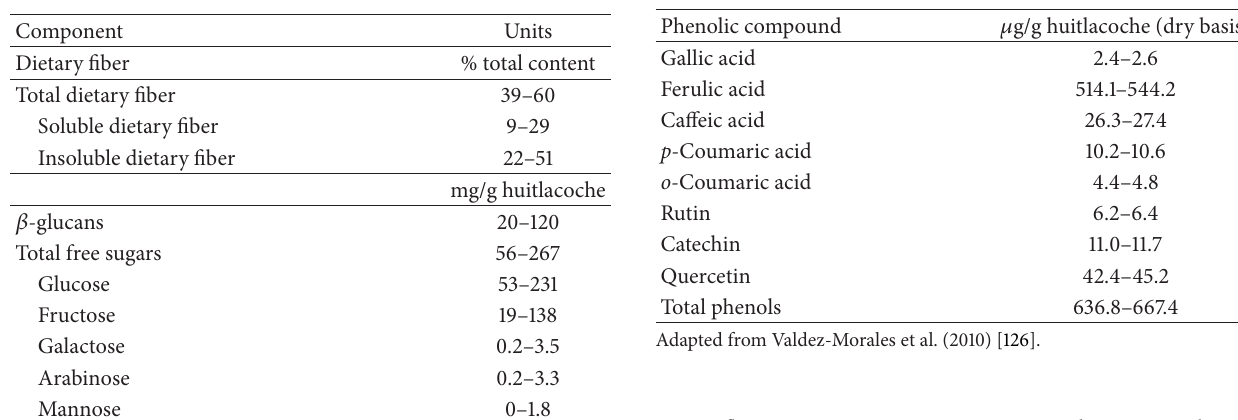
Table 4: Dietary fiber fractions, 𝛽 -glucans, and free sugars in huitlacoche (dry basis).